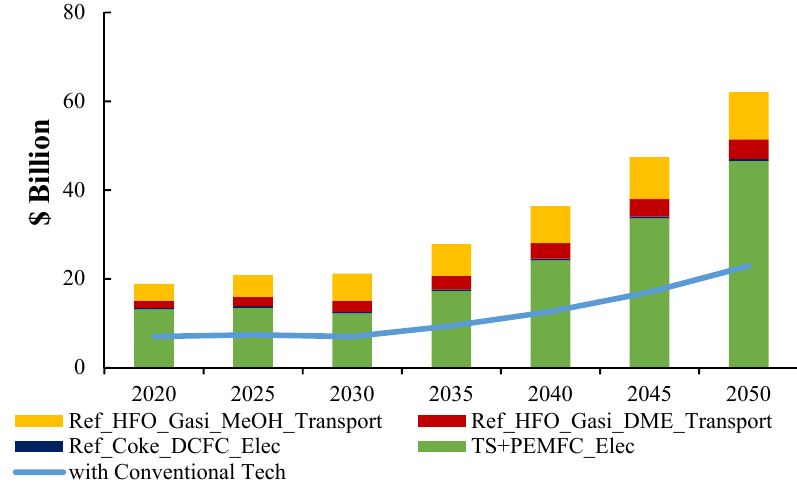
Figure 8. Investment requirements for scenario 1.